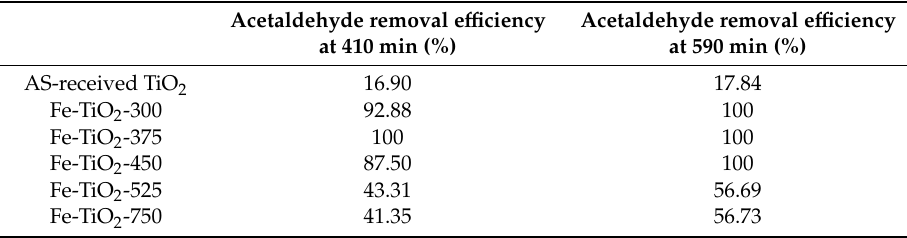
Table 2. Removal e ffi ciencies for acetaldehyde determined after 410 min and 590 min of visible light irradiation in the presence of TiO 2 , and Fe-TiO 2 -300, -375, -450, -525, and